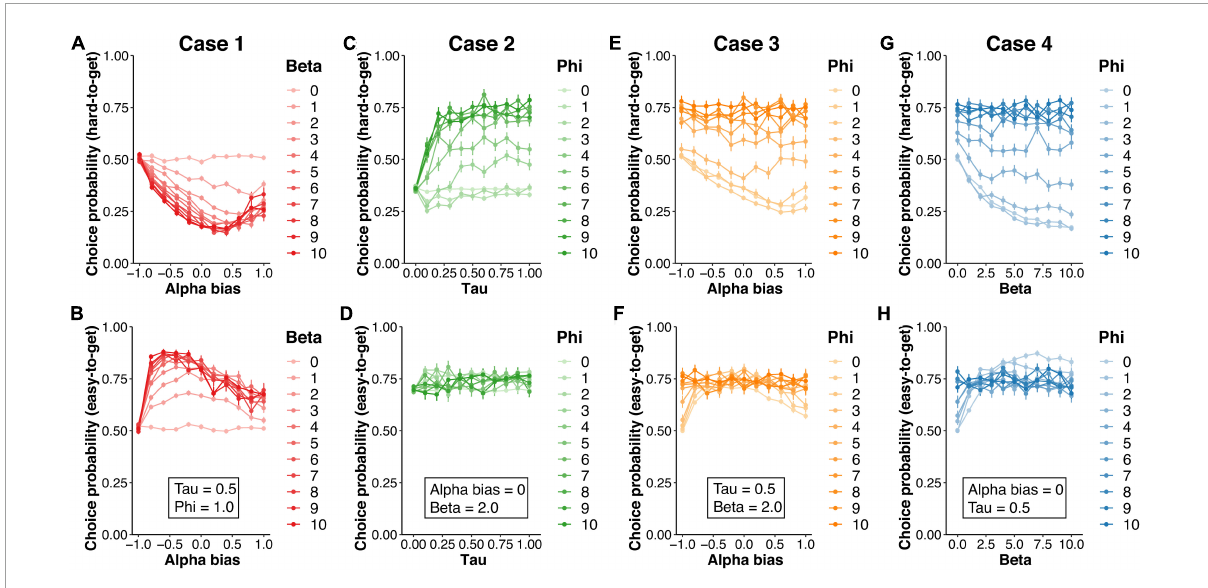
FIGURE4 The results of the simulation in the hybrid model. The simulation of the agent’s choice behavior was generated by manipulating four parameters ( α bias , β , τ , and ϕ ) included in the hybrid model. The upper and lower rows show the choice probability for hard-to-get and easy-to-get avatars, respectively. In case 1, the bias of learning rates ( α bias = α + – α − ) and the inverse temperature ( β ) were varied, while the decay rate ( τ = 0.5) and the weight of choice history ( ϕ = 1.0) were fixed (A,B) . In case 2, τ and ϕ were varied, while α bias (= 0) and β (= 2.0) were fixed (C,D) . In case 3, α ϕ were varied, while ϕ (= 1.0) and β (= 2.0) were fixed (E,F) . In case 4, β and ϕ were varied, while α bias and were fixed (G,H)